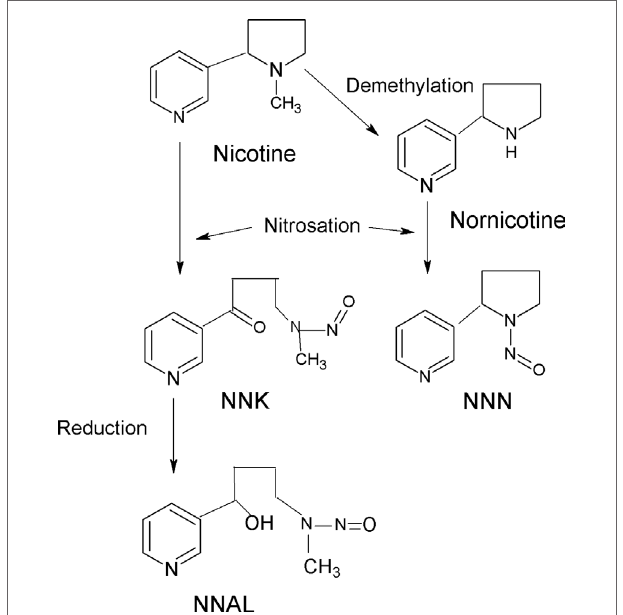
FiGURe 1 | Formation of NNK, NNN, and NNAL